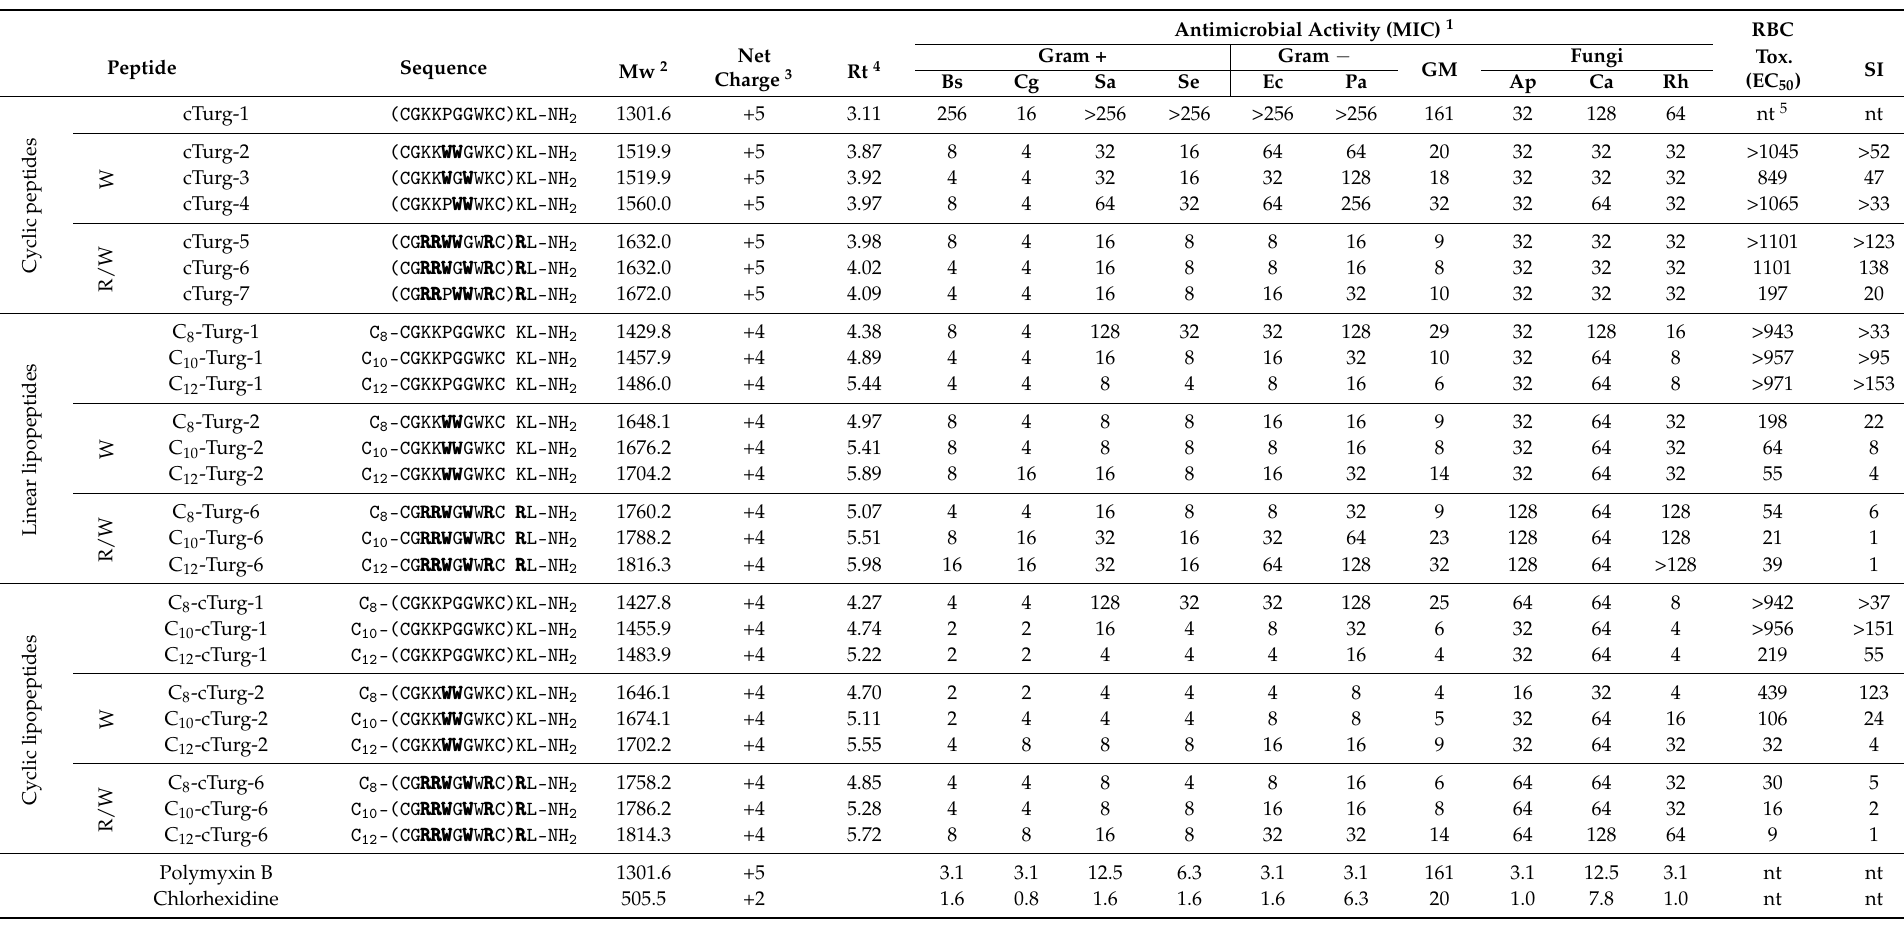
Table 1. Antimicrobial activity (MIC in µ g/mL), haemolytic activity against human RBC (EC 50 in µ g/mL) and selectivity index (SI). Sequence modifications (Trp and Arg replacements) compared to Turgencin A are shown in bold, and sequences in parentheses denote Cys-Cys cyclic peptides. SI was calculated as the ratio between haemolytic activity (EC 50 ) and the geometric mean (GM) of the MIC values against all bacterial strains, i.e., SI = EC 50